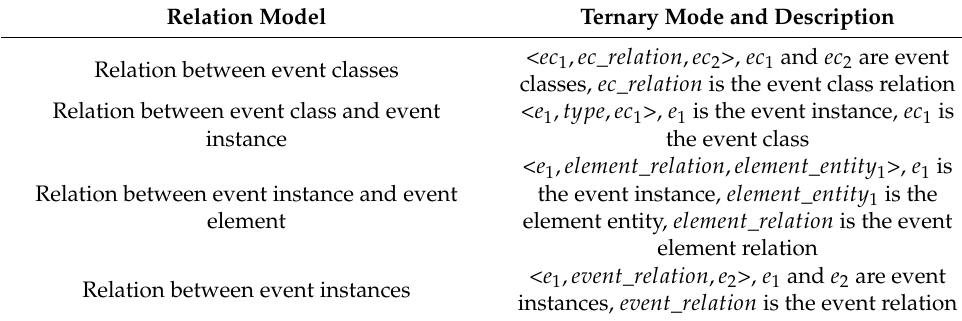
Table 1. Schema of